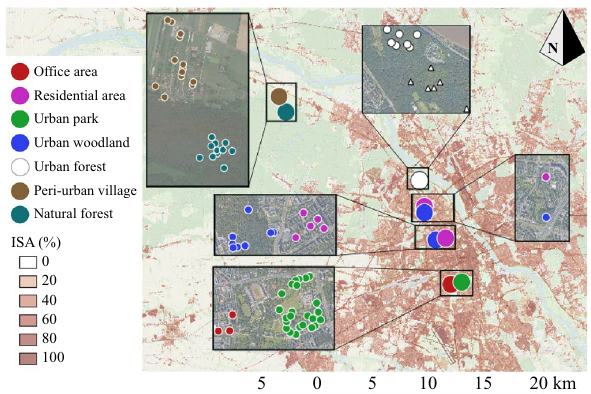
Figure 1. Study site locations in the urban mosaic of the capital city of Warsaw, Poland. The locations include an office area, two residential areas, an urban park, two urban woodlands, an urban forest, a peri-urban village and a natural forest. The impervious surface area (ISA, in %), shown here as the original map layer, is further described and used for analysis in Section 2.2.3. A zoom on each study site visualizes the locations of nestboxes (dots) and natural cavities (triangles). The figure was generated using the QGIS software (v. 3.10) 86